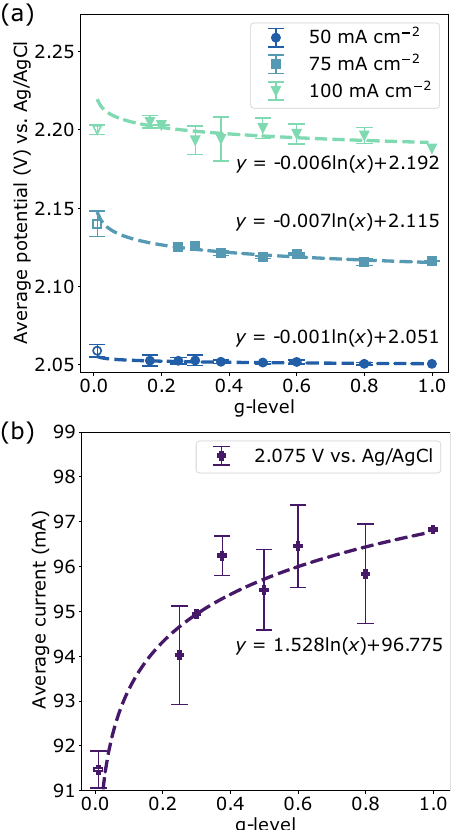
Fig. 3 Reduced gravity gas-evolving electrolysis (0 – 1 g). The average potential or current of all reduced-gravity electrolysis experiments under galvanostatic ( a ) and potentiostatic ( b ) control, respectively (data collected with centrifuge ( fi lled) or stationary (un fi lled) cells). Error bars represent the standard error of the mean. To remove the in fl uence of cell-speci fi c shifted baselines, the average % change from 1 g for each g-level was applied to the mean 1 g value; hence 1 g data points and g-levels where only a single data point was collected are not shown with error bars. Trends shown are calculated based on centrifuge data only and have an R 2 value of 0.848, 0.868, and 0.496 for 50, 75, and 100 mA cm – 2 respectively, and 0.651 for 2.075 V. Source data are provided as a source data fi